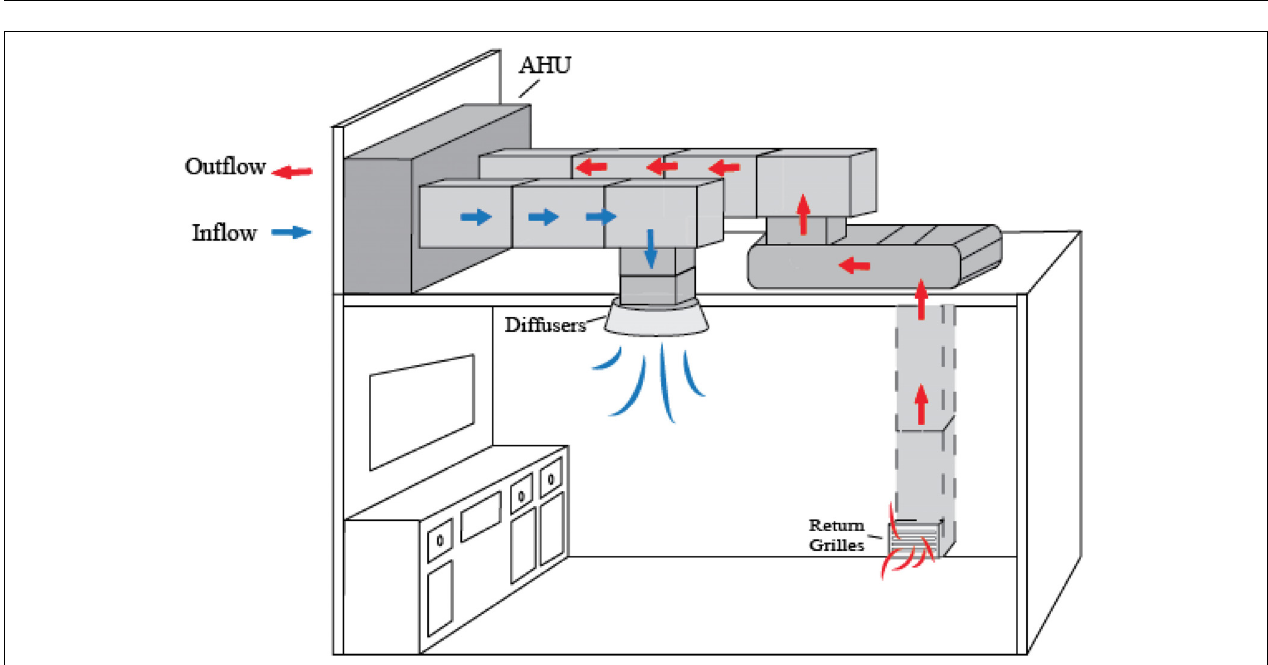
FIGURE 4 | Schema of a variable air volume air handling unit HVAC operational systems.